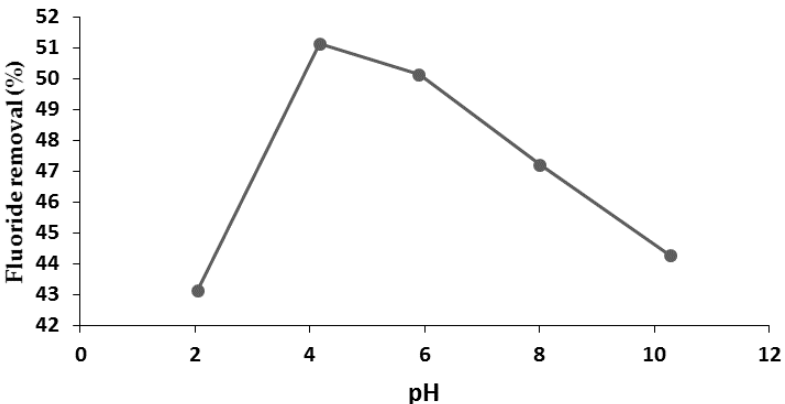
Figure 8. Optimisation of pH (2 g/50 mL, 70 min, 25 °C, 200 rpm).